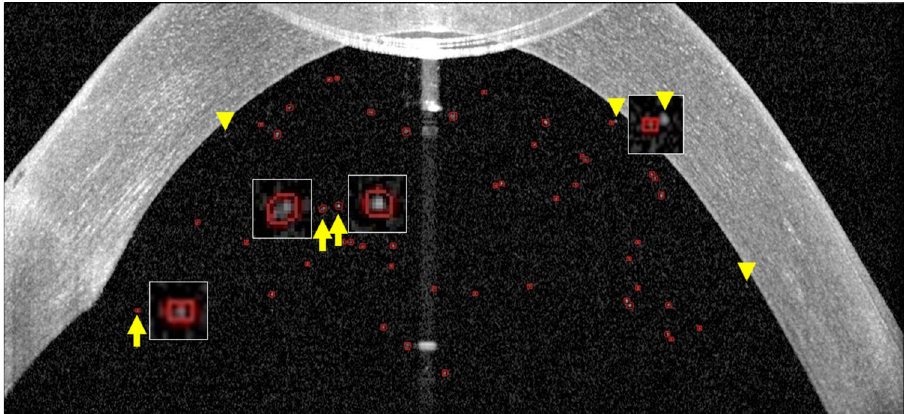
Figure 4. Various shape cell images. When one pixel is recognized as a cell, the area is recognized as 0 because of openCV limitation (left arrow). Large oval cells (middle arrow) and small round cells (right arrow) are also observed. Some cells are not recognized because these are too close to the cornea and covered by a mask